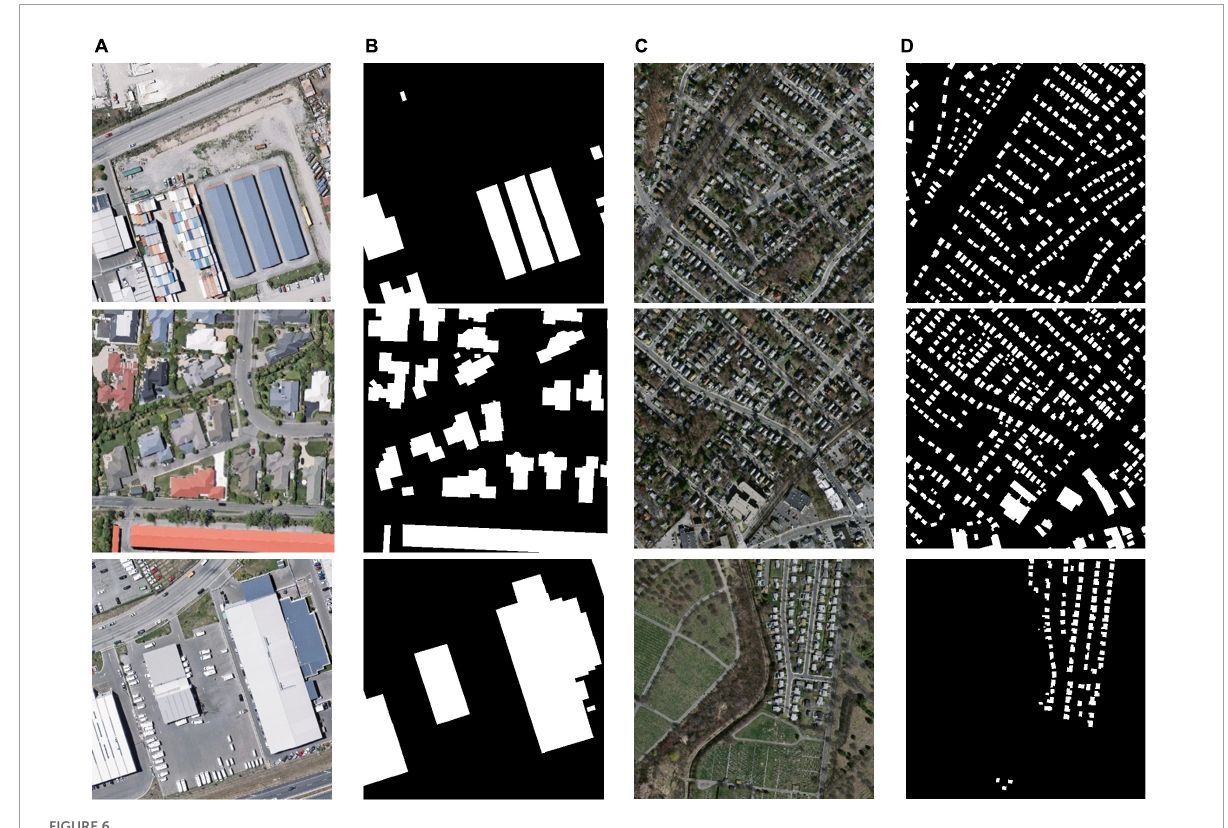
FIGURE6 Images and labels in the WHU building dataset. (A) Original images in WHU dataset, (B) labels of WHU dataset, (C) original images in Massachusetts dataset, and (D) labels of Massachusetts dataset.